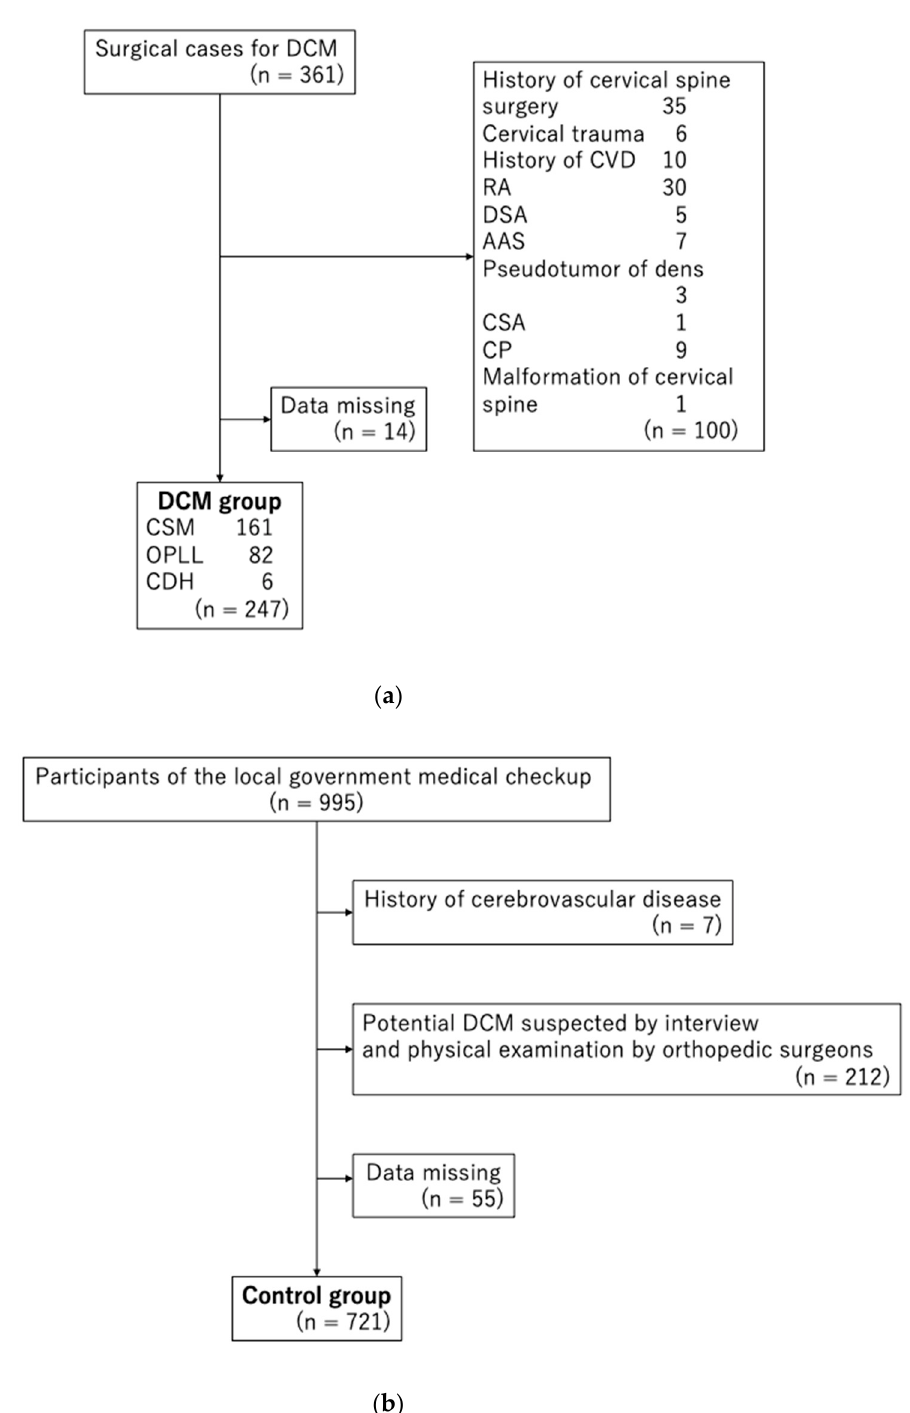
Figure 1. ( a ). Flow chart showing recruitment of the DCM group. DCM, degenerative cervical myelopathy; CVD, cardiovascular disease; RA, rheumatoid arthritis; DSA, destructive spondyloarthropathy; AAS, atlanto-axial subluxation; CSA, cervical spondylotic amyotrophy; CP, cerebral palsy; CSM, cervical spondylotic myelopathy; OPLL, ossification of posterior longitudinal ligament; CDH, cervical disc herniation. ( b ). Flow chart showing recruitment of the control group. DCM, degenerative cervical myelopathy.